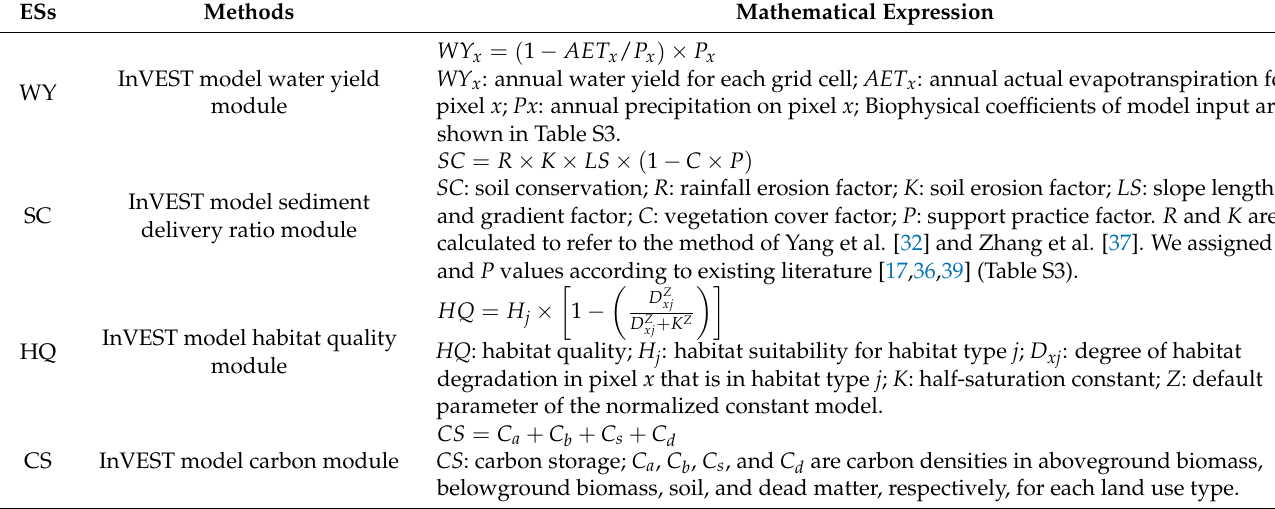
Table 2. Methods for quantifying